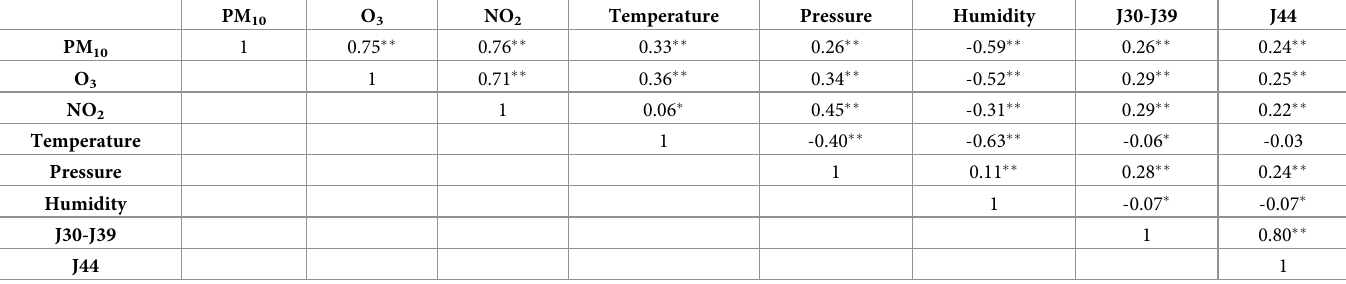
Table 2. Pearson’s correlation coefficients between air pollutants, weather variables, and out-patient visits due to upper respiratory tract (J30-J39) and pulmonary (J44) diseases. ( � p < .05, �� p < .01). PM 10 O 3 NO